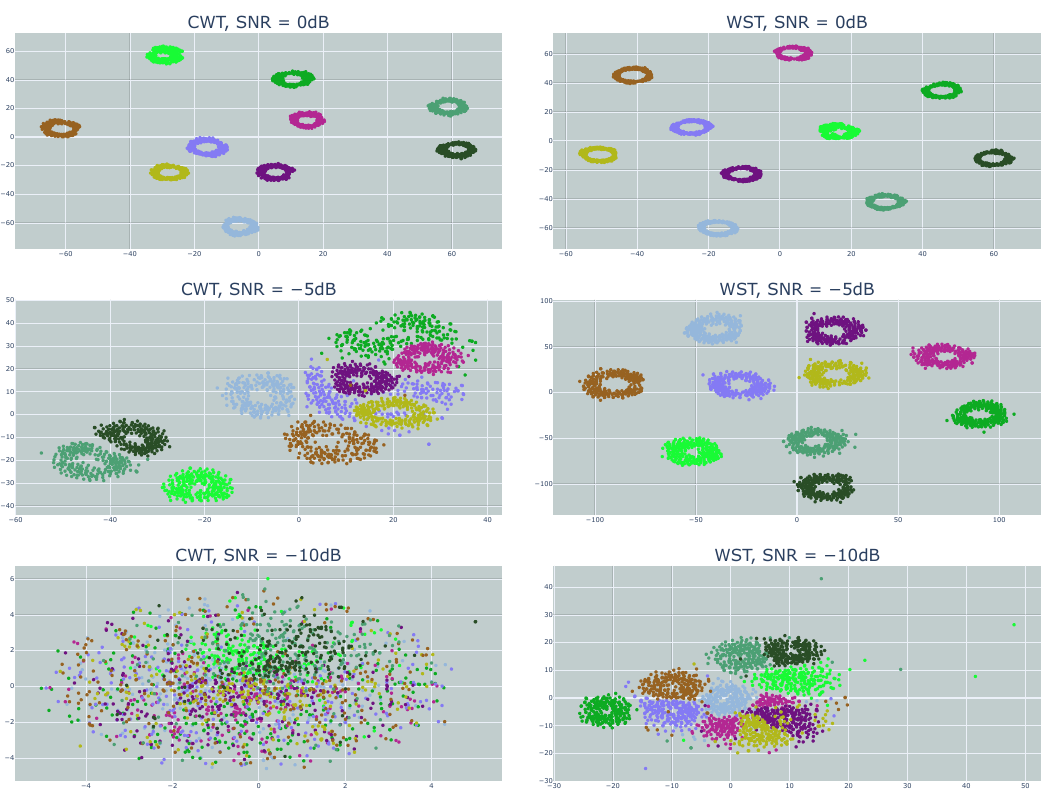
Figure 12. Clustering results using t-SNE with WST and CWT for different SNR values. −10